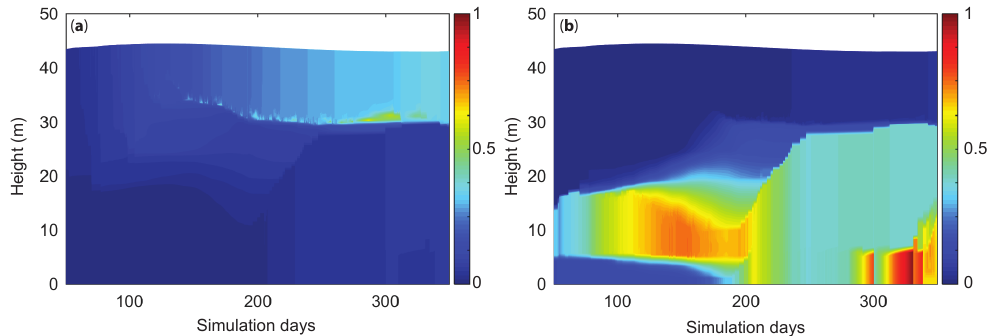
Figure 12. Example simulations with tracers demonstrating inflow insertion example for the case in which (a) the inflow was set as a surface river inflow and subject to the insertion algorithm (Eqs. 60–67) prior to insertion, and (b) the inflow was set as a submerged inflow at a specified height ( h inf = 5m). Once entering the water column, the tracer, C , is subject to mixing during inflow entrainment in case (a) and by surface and/or deep mixing once inserted for both cases (a) and (b) . The colour scale represents an arbitrary inflow concentration which entered with a value of